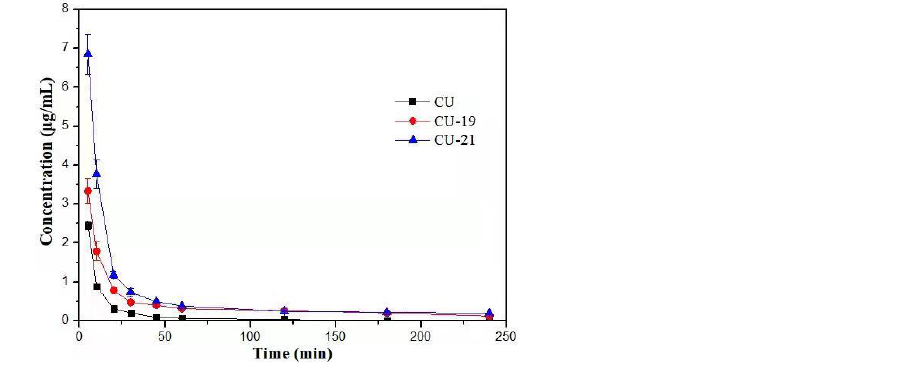
Figure 7. Mean (±SD) plasma concentration – time profiles of CU-19, CU-21 and CU in the plasma of healthy rats ( n = 4), which were administered a single intravenous dose of 20 mg compound per kg of body weight. Table 4. Pharmacokinetic characteristics of CU-19, CU-21 and CU in the plasma of healthy rats ( n = 4), which were administrated a single intravenous dose of 20 mg compound per kg of body weight. Results are shown as the mean ± SD, n = 4.